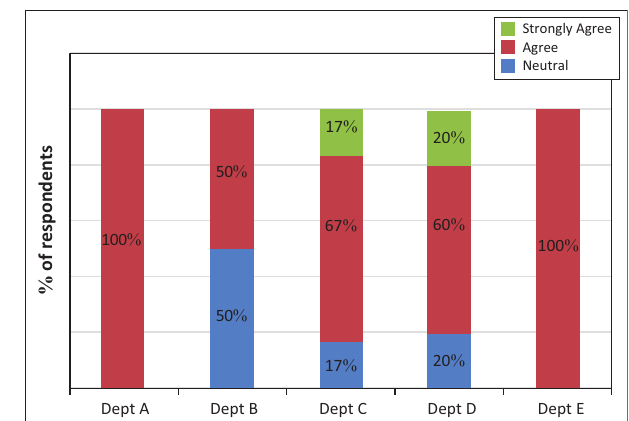
FIGURE 8: Online Research Output Submission System is a simple, easy-to-use web-based tool.